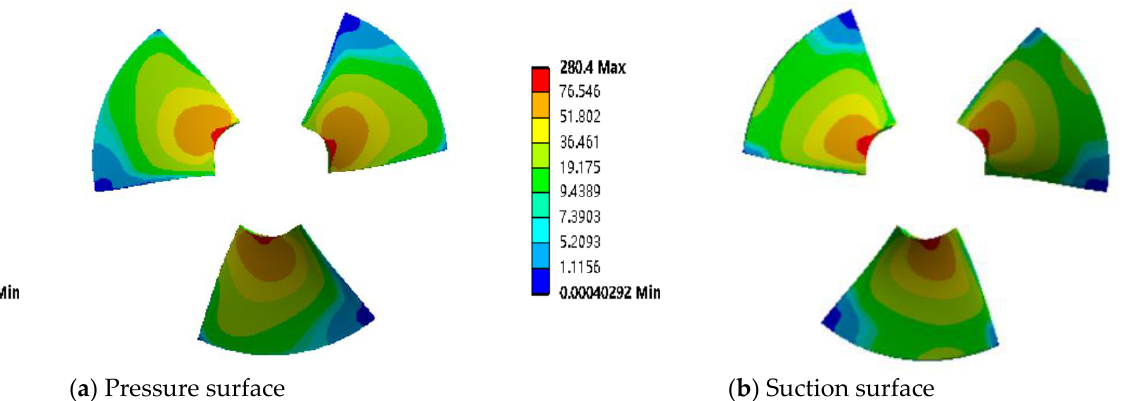
Figure 14. Q = 10 m 3 /s Equivalent stress distribution of impeller, Unit: MPa.